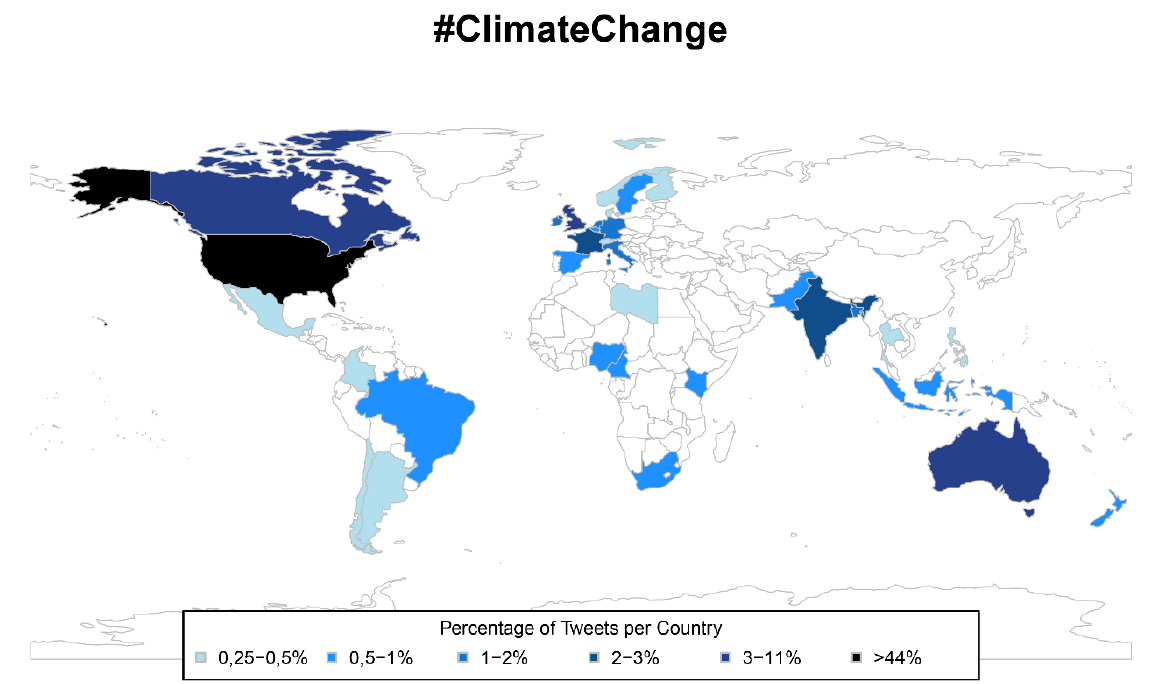
Figure 1. World map of Twitter activity for #ClimateChange between August 2015 and January 2018. Note: A detailed fre- quency table for all countries is provided in Supplementary File, appendix A. Source: Author, prepared with R worldmap.